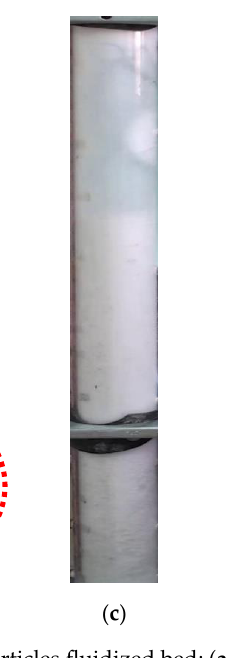
Figure 3. Digital images of solid particles fluidized bed; ( a ) Glass beads; ( b ) Titania; ( c )